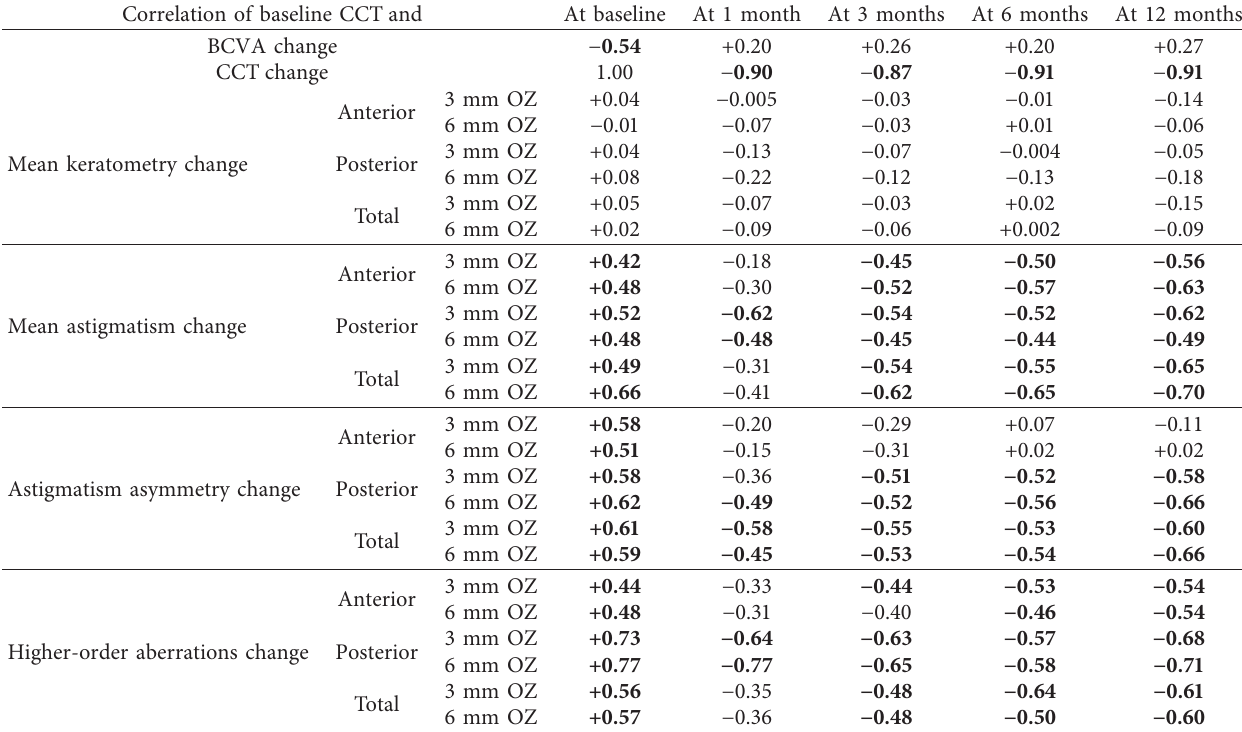
Table 4: The correlations between baseline CCT and the changes in VA, CCT, keratometry, astigmatism, astigmatism asymmetry, and higher-order aberration values obtained in the 3 and 6 mm optical zones after DMEK surgery. Correlation of baseline CCT